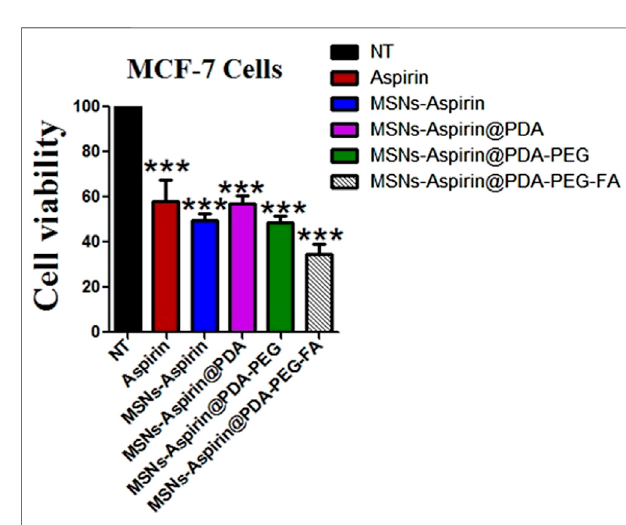
FIGURE4| MTTassaybased cellsviabilityofMCF-7 breastcancercells examined at 48 h; Cell culture is treated with Negative control (NT), free drug (Aspirin), drug-loaded in MNPs (MSNs-Aspirin), and all other derivatives of AspirinloadedMNPspreparedinthisstudy(MNP-Asp@PD,MNP-Asp@ PD-PG, and